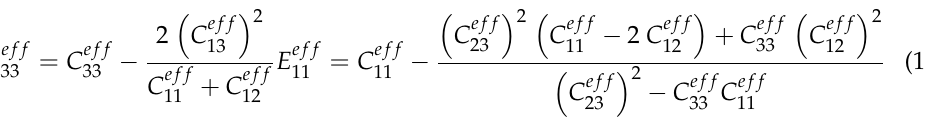
Figure 10. Degraded material properties area and different types of void in the composite materials.